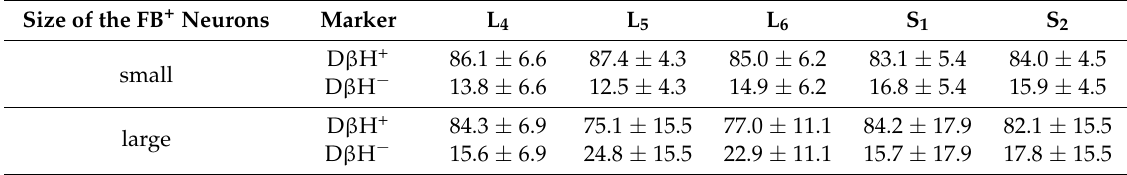
Table 3. Percentages of retrogradely labeled small- and large-sized neurons in the porcine